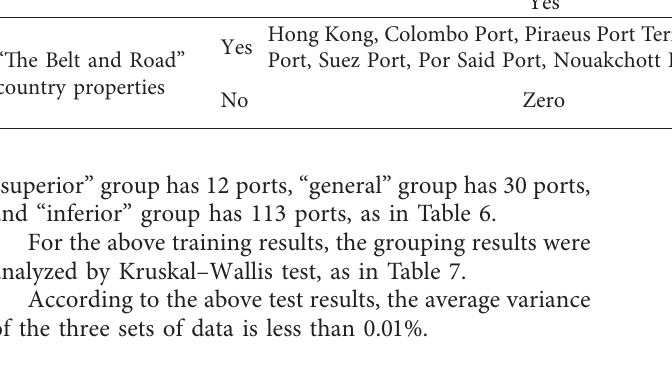
Table 9: A double attribute category table for strategic pivot ports. Whether Chinese companies participate in